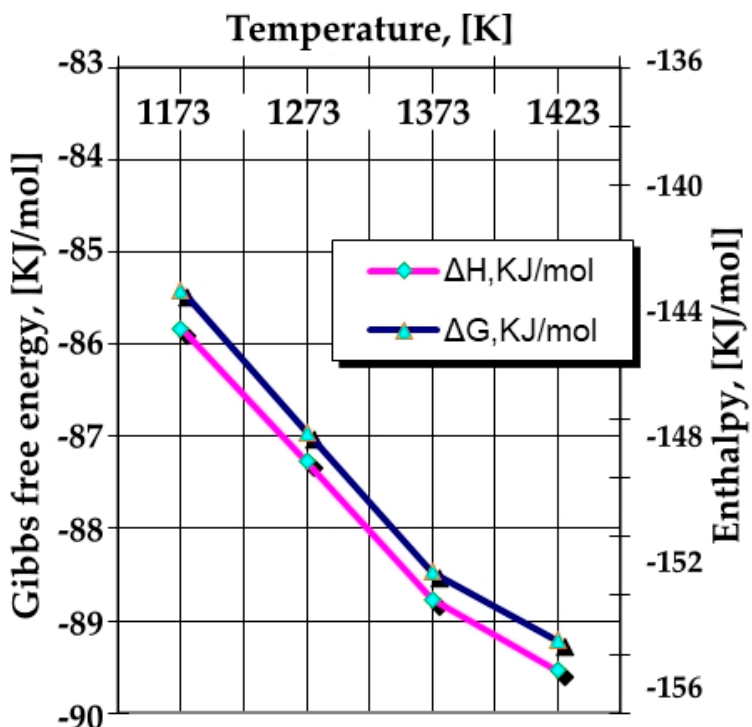
Figure 4. The evolution of the main thermodynamical properties specific to Equation (22) with temperature, was obtained with the help of Outotec’s HSC 6.12 Chemistry Software [19]. Note that the nitrogen in the atomic state can be obtained by thermocatalytic decom- position of ammonia at the metal product interface, as is shown in Equation